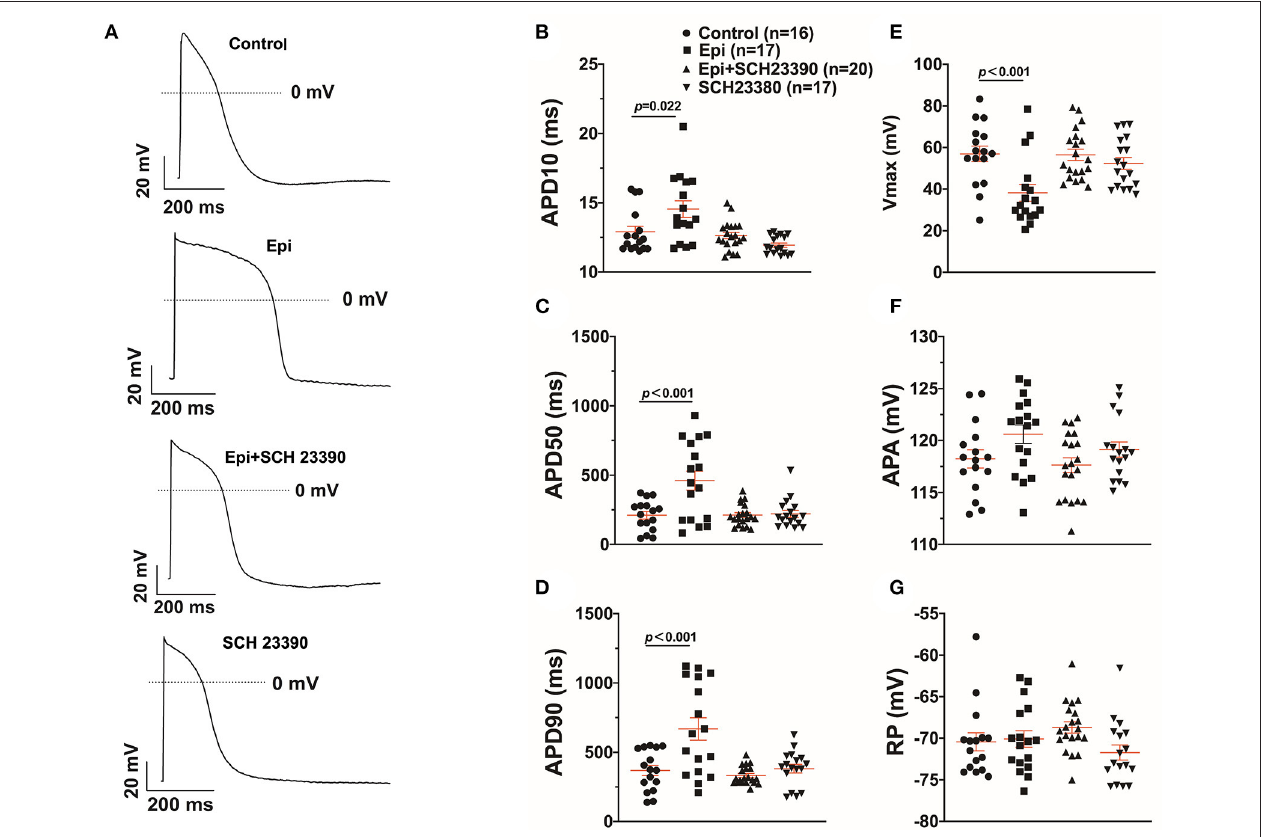
FIGURE 2 | Dopamine D1/D5 receptor signaling contributed to effect of epinephrine on action potential. hiPSC-CMs were challenged by either vehicle (Control) or 500 µ M epinephrine (Epi) or epinephrine plus 10 µ M SCH 23390 or SCH 23390 alone for 1h. Action potentials (APs) were recorded at 1Hz. (A) Examples of APs in a cell of each group. (B) Mean values of APD10 in each group cells. (C) Mean values of APD50 in each group cells. (D) Mean values of APD90 in each group cells. (E) Mean values of Vmax of APs in each group cells. (F) Mean values of AP amplitude (APA) in each group cells. (G) Mean values of resting potential (RP) in each group cells. “ n ” numbers in (B) are for (B–G) . The p -values vs. Control were decided by the analysis of one-way ANOVA with Holm-Sidak